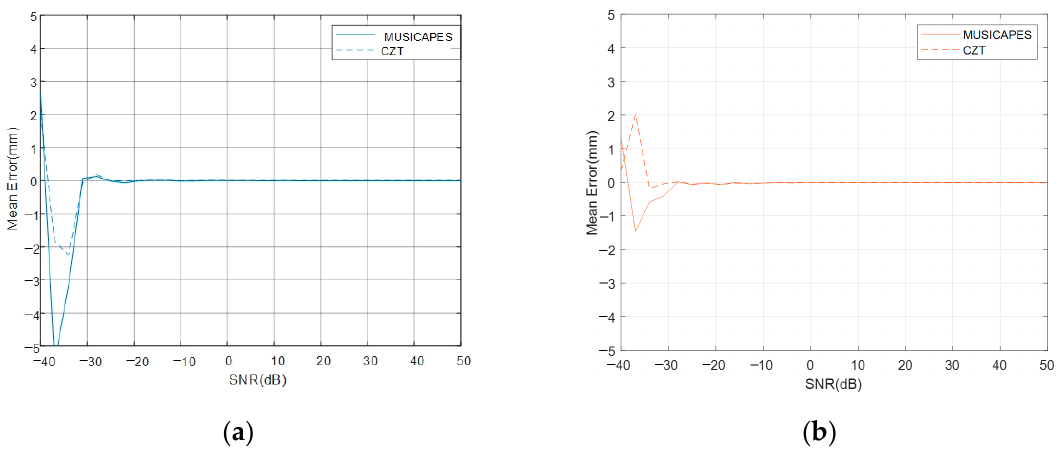
( b ) Figure 10. STD of displacement difference vs. array length. ( a ) STD of ‘Target1’; ( b ) STD of ‘Target2’. 4.1.4. Measurement Performance of Two Targets vs. SNR In this simulation case, the number of transmitting receiving antennas are set as three and four, respectively. There are also two targets. ‘Target1’ is fixed at (20 m, 0°) and ‘Tar- get2’ is fixed at (20 m, 4.23°). The angle interval between them is half the angular resolu- tion of the MIMO array. The real displacement curves of the two targets are illustrated in Figure 6a. We will analyze the measuring performance as the input SNR varies from − 40 dB to 50 dB with a stride of 3 dB.